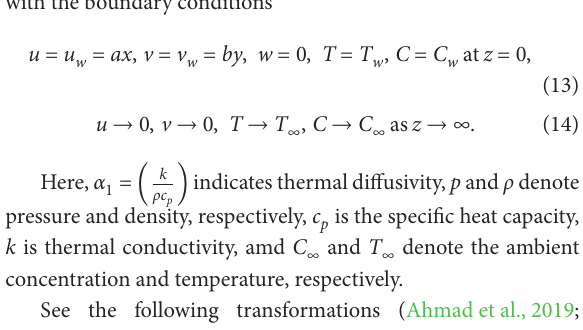
with the boundary